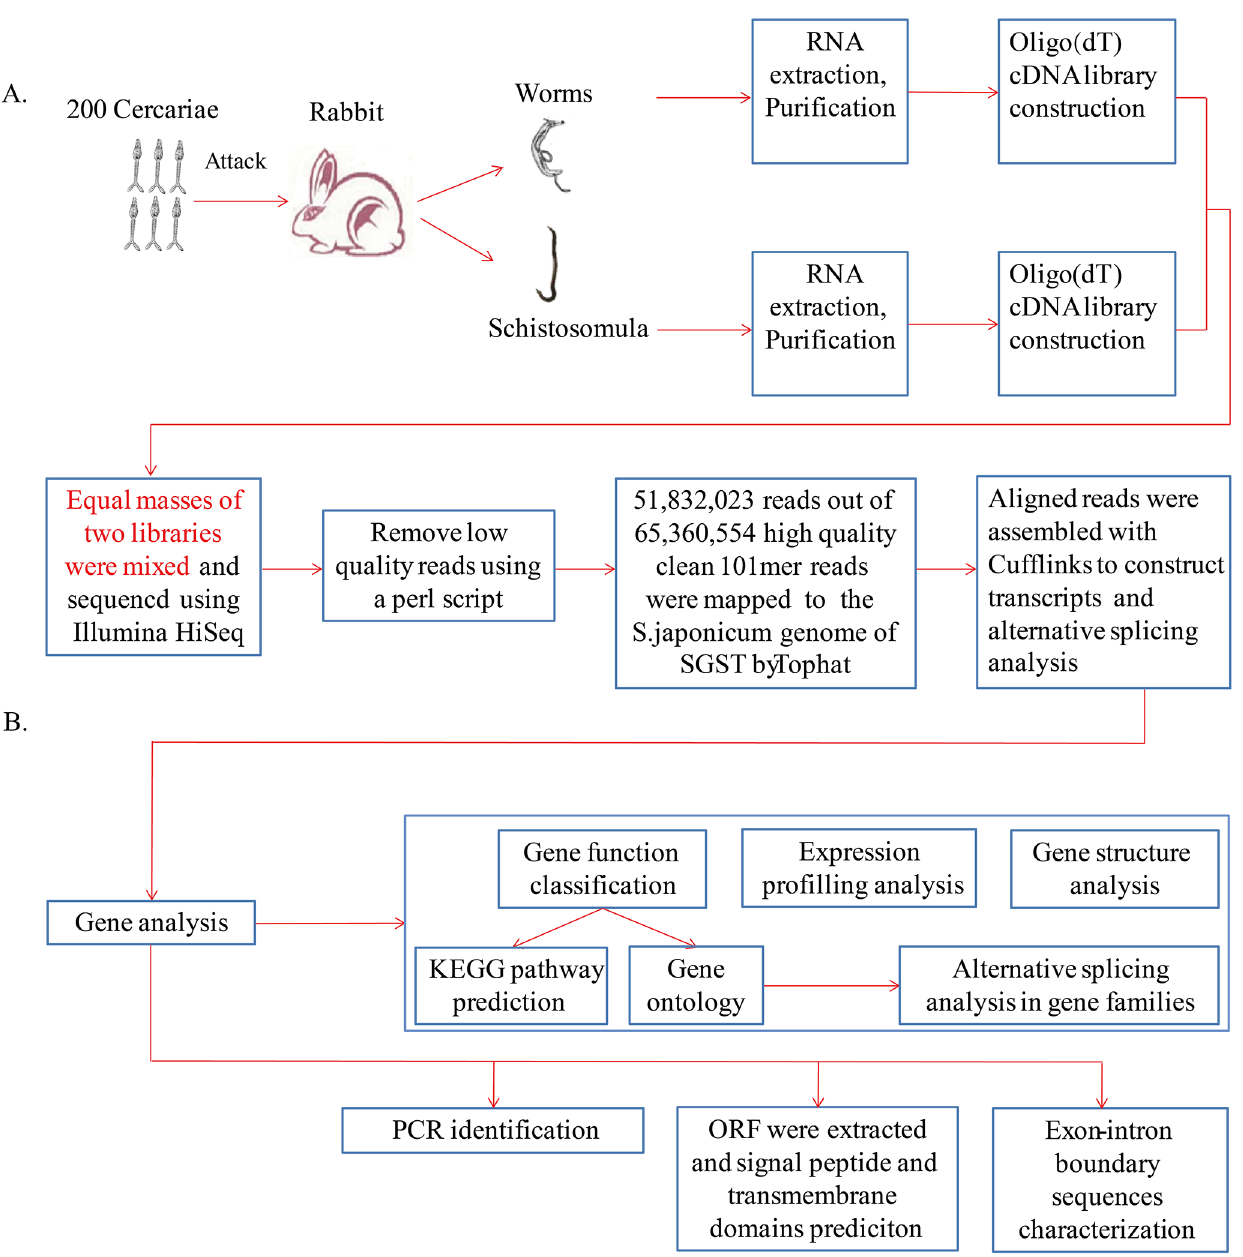
Fig 1. Outlines of RNA-seq and data analysis for identifing AS in Schistosoma japonicum . A, Design and material collection for RNA-seq. The library sequenced here was mixture of equal amount cDNA of adult worms and schistosomula. B, Computational data analysis and experimental idenfication.